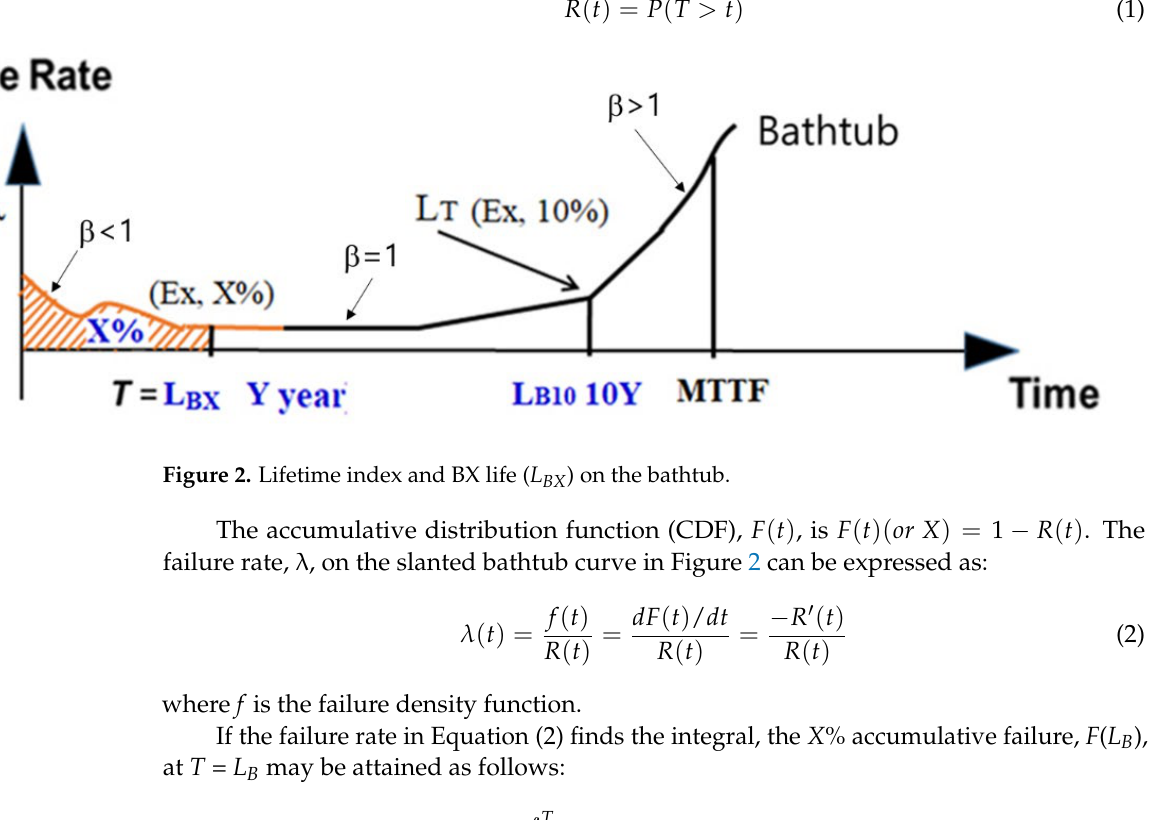
4 of 23 Figure 1. System life resolved by new subsystem (or module): ( a ) a systematic classes of multi-mod- ule refrigerator; ( b ) product life L B . To carry out a parametric ALT, the BX lifetime (or “Bearing Life”), L B , might be de- termined as an index of the system life. The BX lifetime metric originated from the bearing manufacturing but has become an index for product lifetime that can be employed in var- ious industries today. That is, BX life is a passed time when X% of a group of products under consideration is unsuccessful. A “BX life Y years” is a manner for showing the prod-